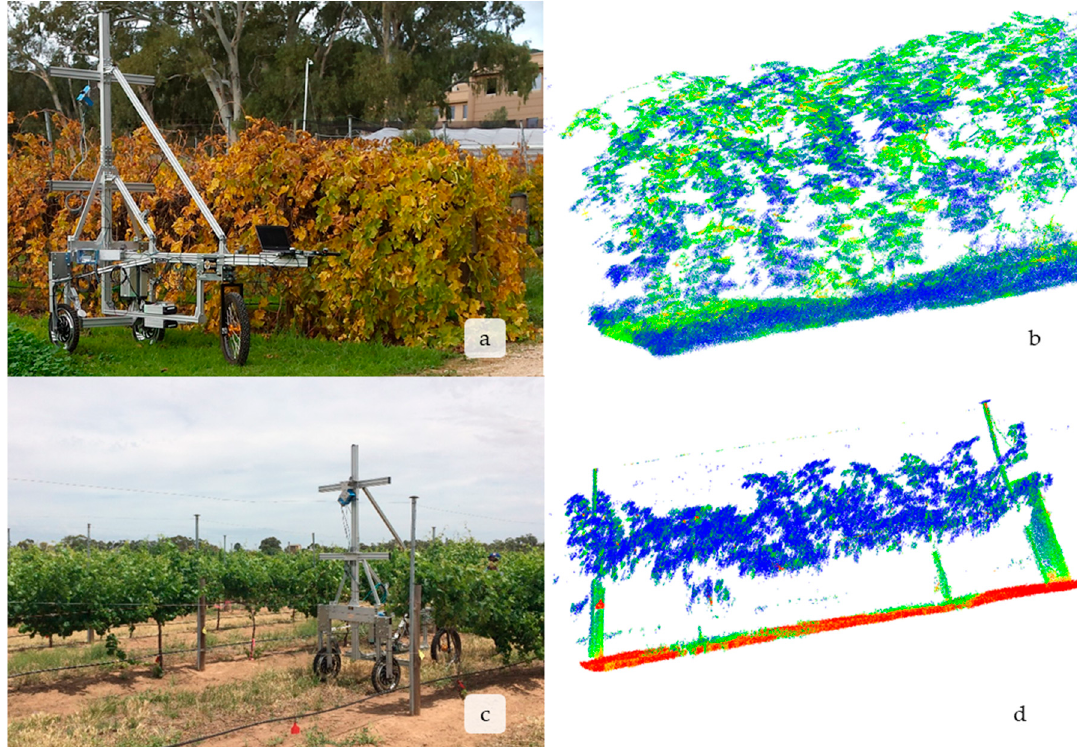
Figure 3. This demonstrates GRover’s ability through the LMS-400 to capture diverse features of vine growth. This includes minimally pruned vines ( a , b ) and spur-pruned vines trained to a two-wire vertical trellis ( c , d ); right panels are the LiDAR scans that were produced from the use of GRover. Pictures of GRover in the field taking the scans are to the left. All scans are shown after they were pre-processed according to the steps outlined in Figure 2. Both panels show the 3D point cloud produced and relative intensity of each point from the scan. Note how the intensity of the LiDAR return allows for visual distinctions between wood, leaf and even leaves at different phenological stages. The blue points, green leaf tissue ( d ), have the lowest intensity values and are the least reflected. Active, photosynthetic leaf tissue absorbs much more red light ( d ) than older senescent, yellow leaves ( c ) or woody tissue ( b , d ) which appear green ( b , d ). The brown soil and the identification tags on the posts in 3d are the most reflective objects and appear red.